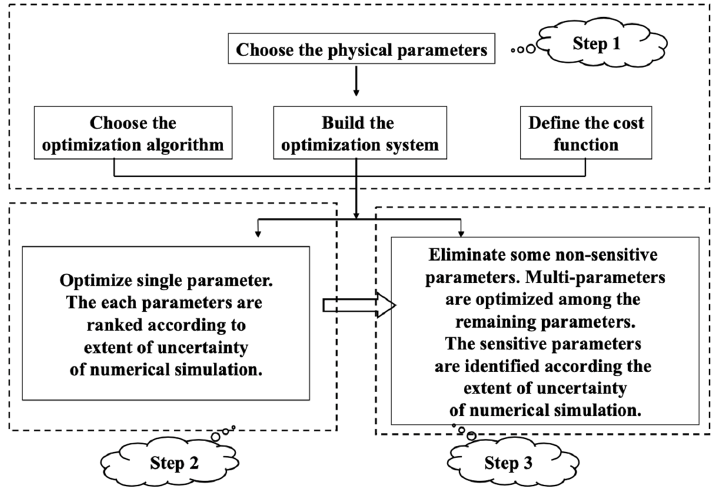
Figure 1. Flowchart depicting the steps involved in the SA method based on CNOP-P (From re- search findings by Sun and Mu